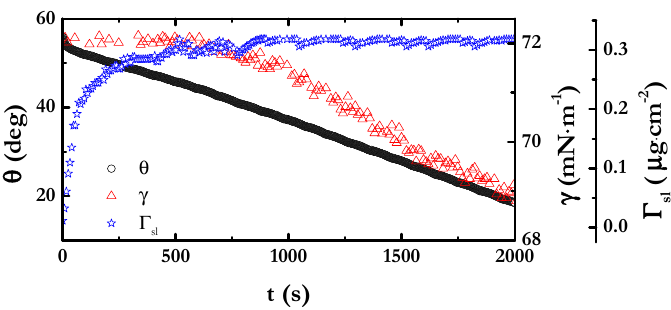
Figure A1. Time dependences of the contact angle θ of a sessile droplet of a PDADMAC–SLES mixture during evaporation on a silicon wafer at relative humidity of 60%, the surface tension of the liquid/vapor interface γ during the adsorption of a PDADMAC–SLES mixture and the surface excess of the solid/liquid interface during the adsorption of a PDADMAC–SLES mixture. The three experiments correspond to a PDADMAC–SLES mixture with a PDADMAC concentration of 5 g/L and (SLES) = 2.62 μ M.